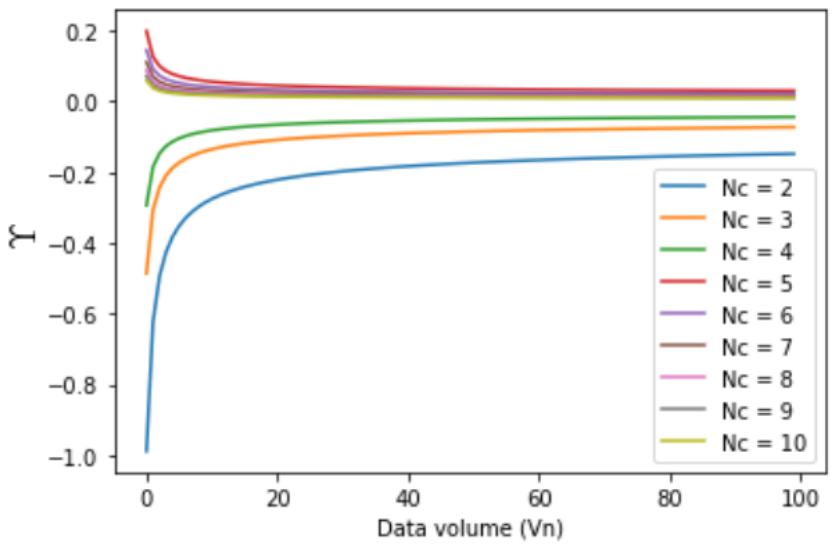
Figure 6. Variation of irrelevance score Υ with ( Υ CL =